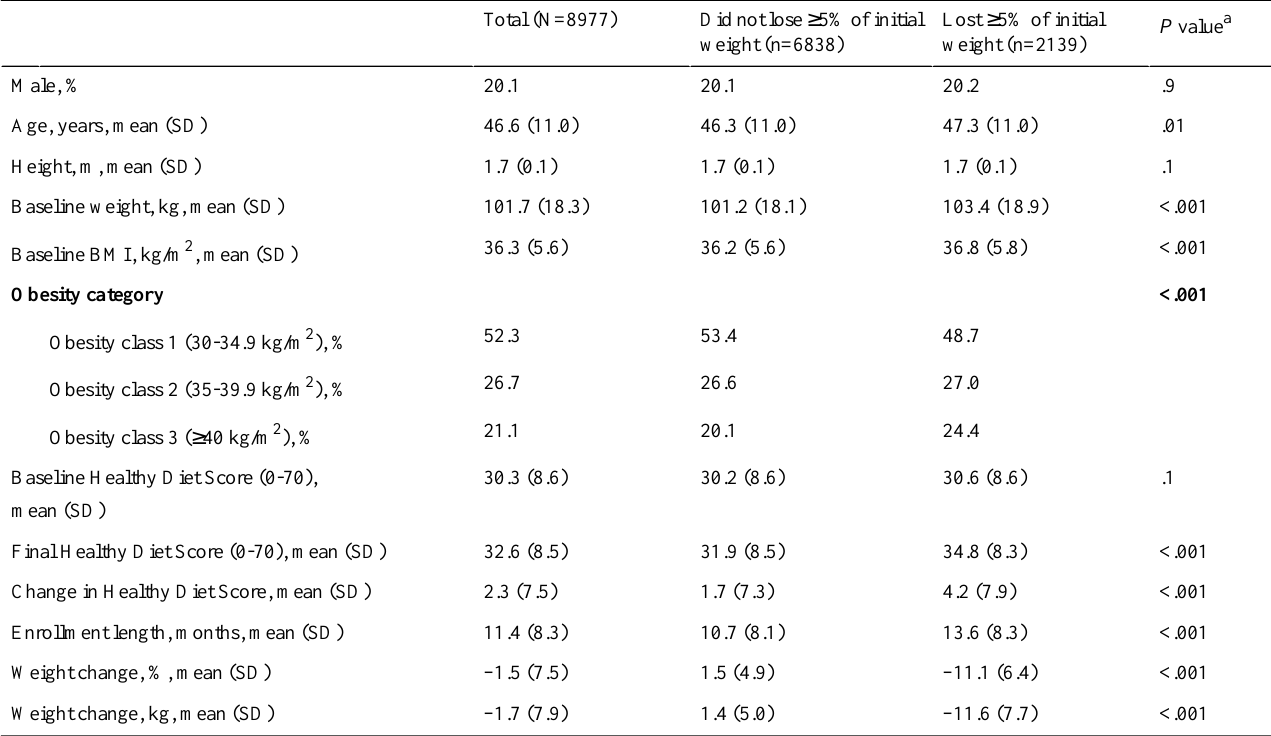
Table 2. Baseline characteristics of Foodsmart